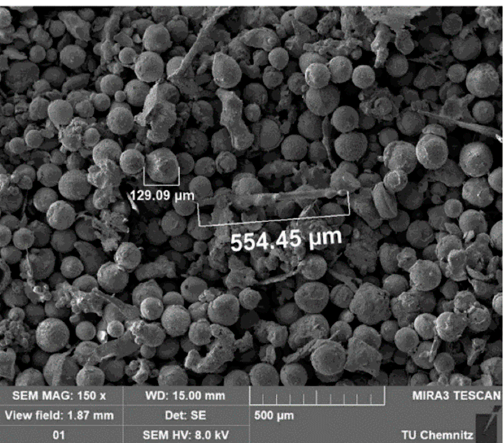
Figure 19. Particle structure and dimensions of metal powder ( v w = 6 m·min − 1 , pulsed direct cur- rent).